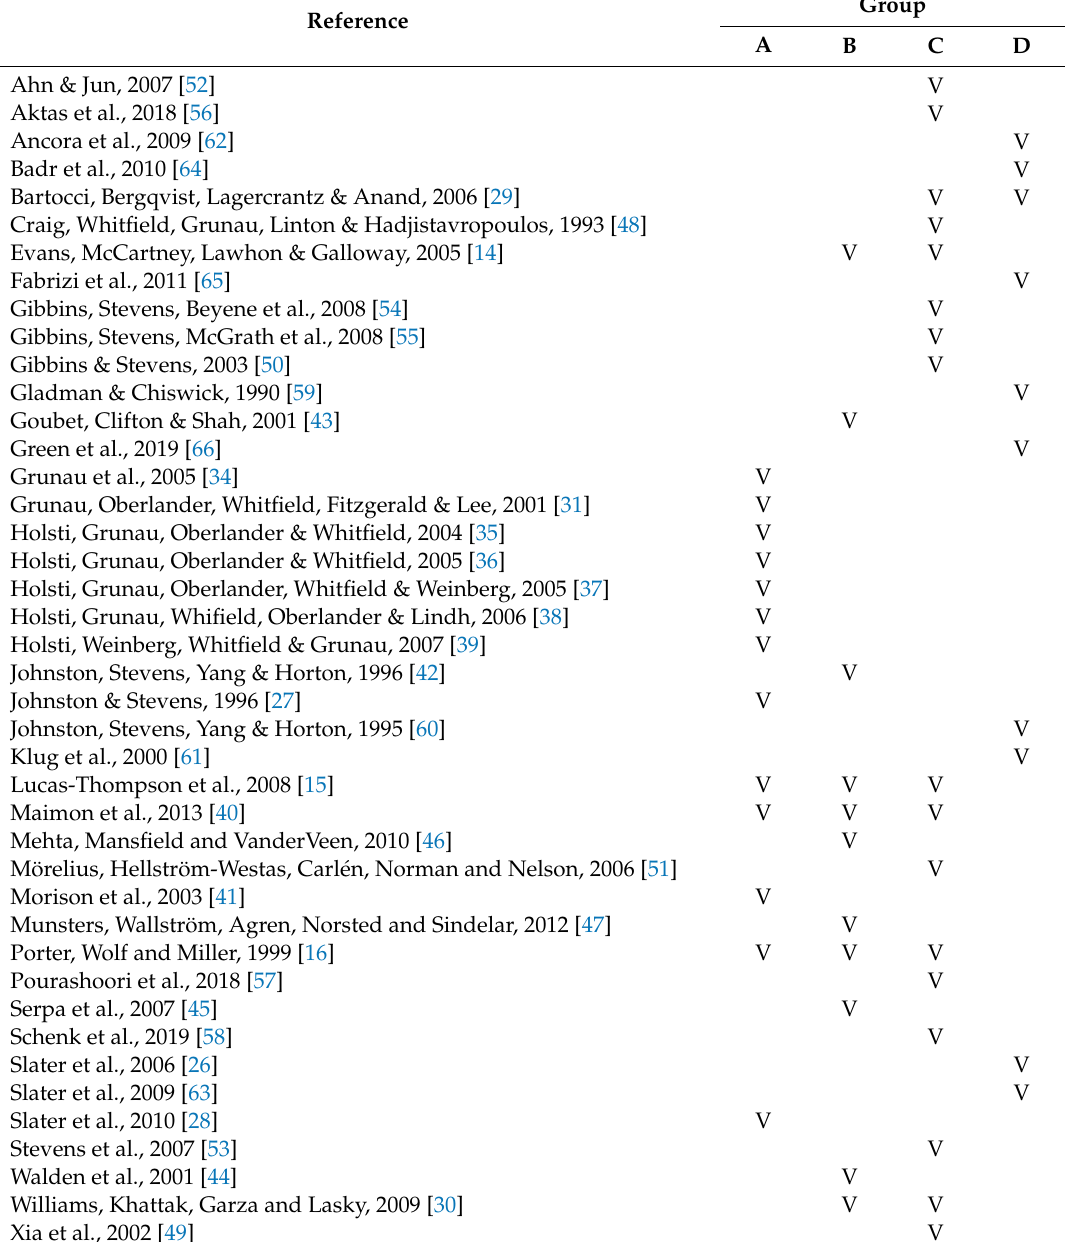
Table 1. Studies included and group membership based on age-sampling